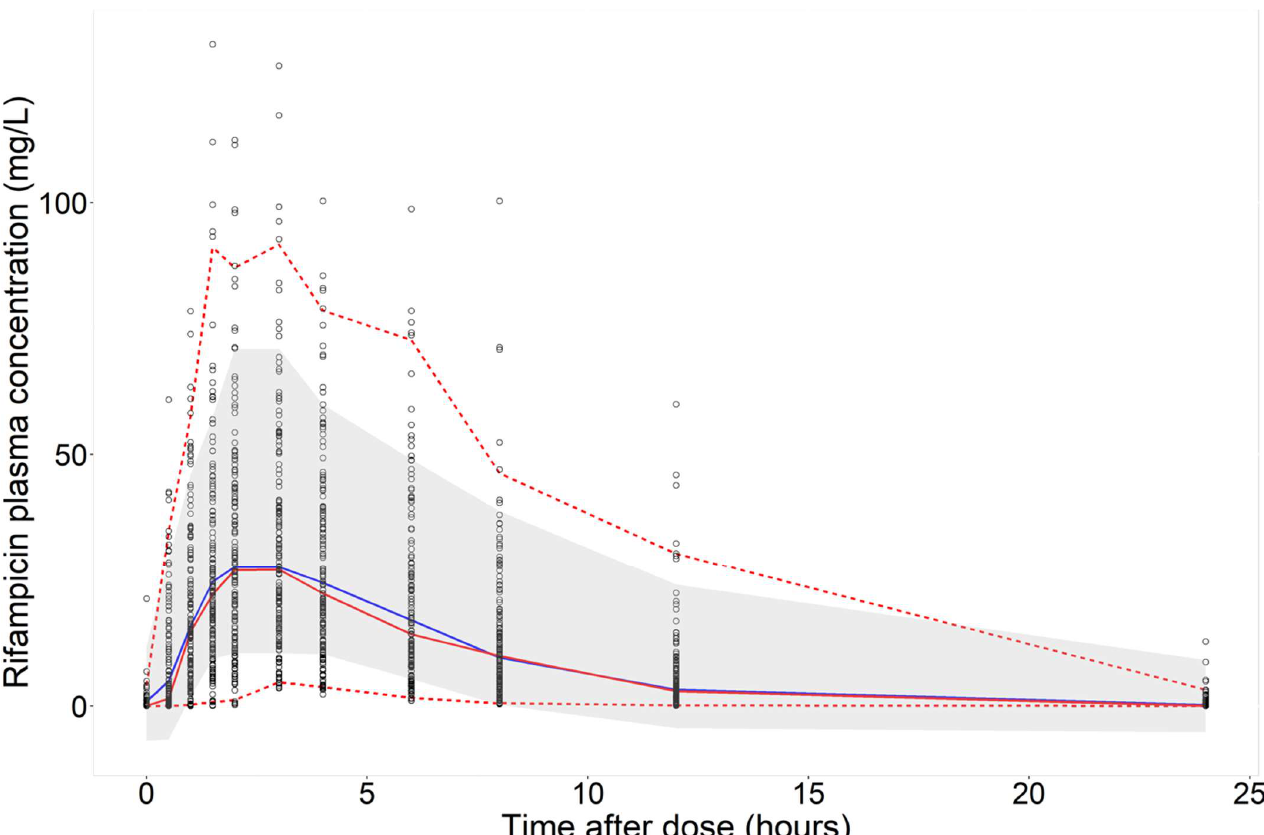
Figure 6. Prediction interval visual predictive check for the best-performing model (XGBoost) trained using 6 plasma concentrations as input (scenario 3) shown for the whole population. Open circles are the rifampicin plasma concentrations simulated from the population PK model, considered to be observed data in this study. The shaded area is the 95th prediction interval of the machine learning model predictions (XGBoost) and the solid blue line is the median of the model predictions. The upper and lower red dashed lines are the 97.5th and 2.5th percentiles of the observed data, respectively, and the solid red line is the median of the observed data.